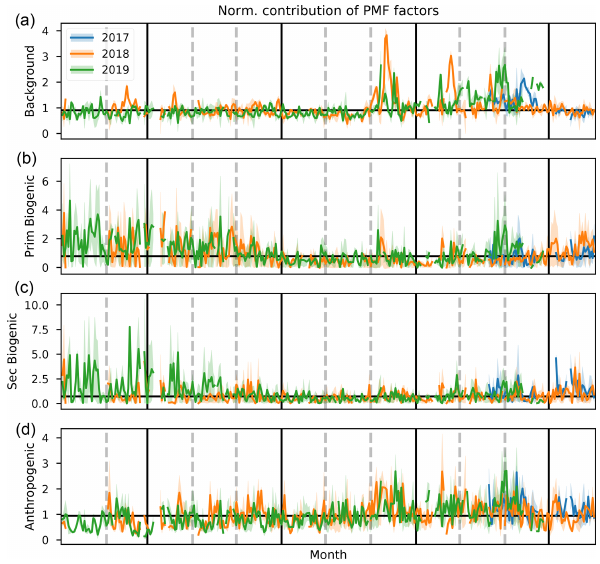
Figure 11. Daily average values of normalized contribution of the background, primary biogenic, secondary biogenic, and anthro- pogenic source factors (a–e) for 2017, 2018, and 2019 (blue, or- ange, and green, respectively). Shaded areas behind the curve show the diel interquartile range. The horizontal black line corresponds to the median daily average over the complete measurement period. Vertical gray dashed lines indicate the end of a month, and vertical black lines separate the DJF, MAM, JJA, and SON seasons.